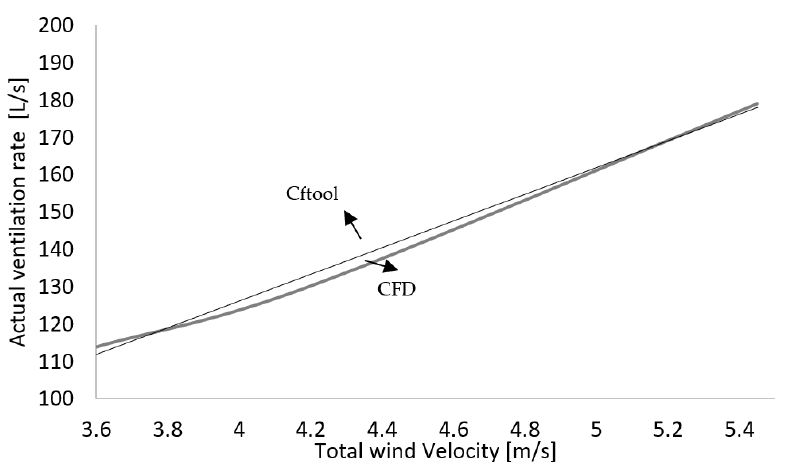
Figure 21. Actual ventilation rate with respect to the total wind velocity.